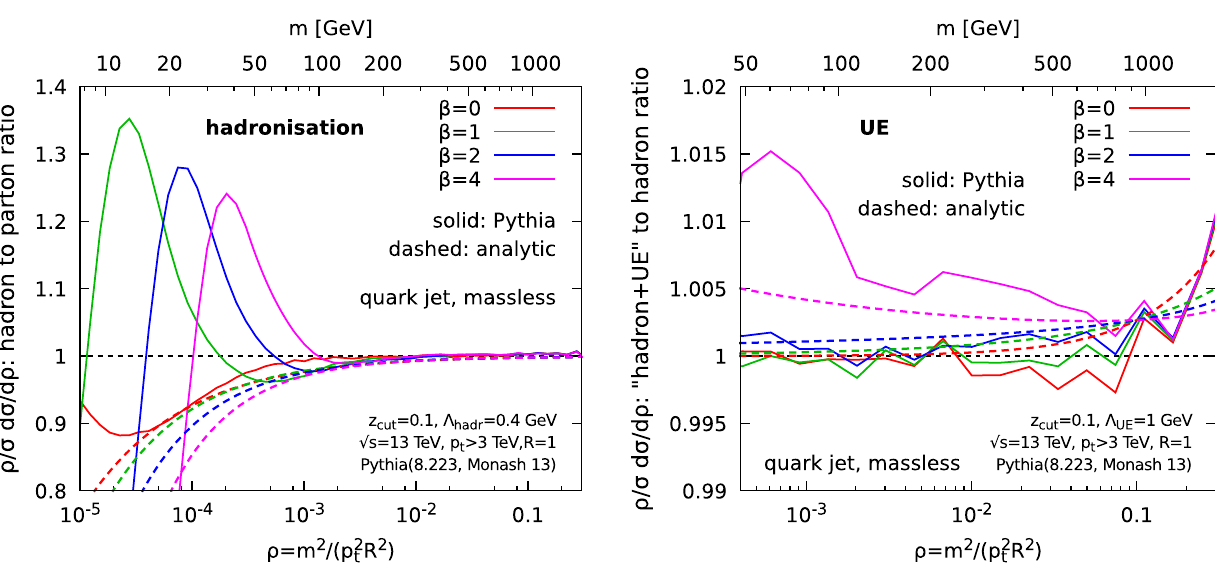
Fig. 1 Comparison of our theoretical estimate of hadronisation cor- rections to what is implemented in a standard Monte-Carlo parton shower, for different values of the angular exponent β , z cut = 0 . 1 and R = 0 . 8. Quark jets are considered and hadron masses are neglected.